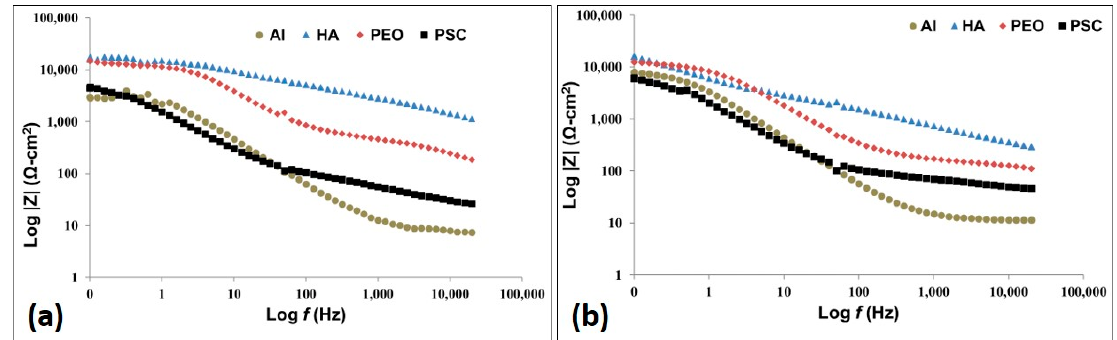
Figure 19. Nyquist plots for the materials after ( a ) 0 day and ( b ) 10 days.